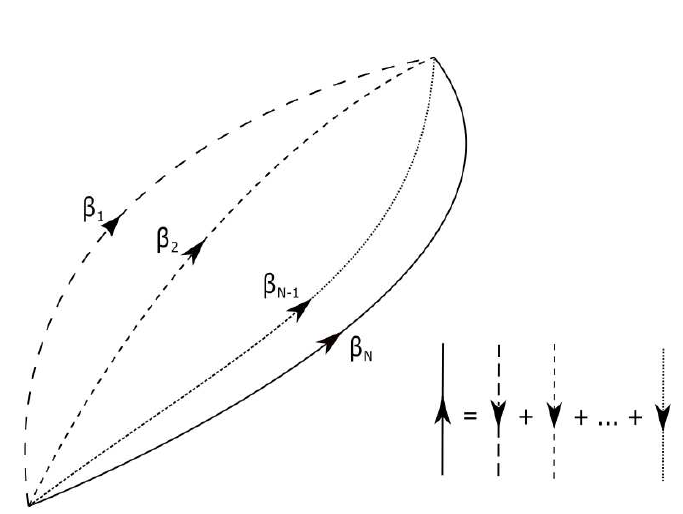
Figure 1 . An N center-vortex creation-annihilation process can be thought of as N loops. The loop l i is formed by joining γ i with